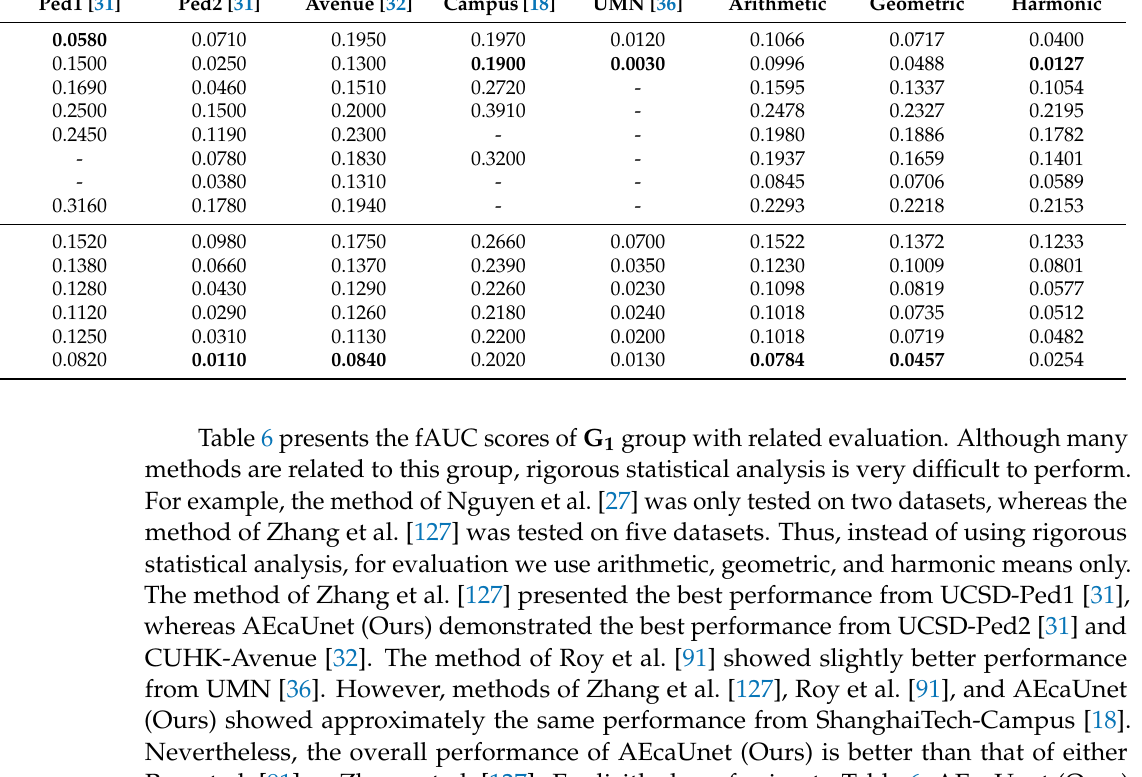
Table 6. The fAUC scores of G 1 . Column-wise the best numerical result is shown in bold .